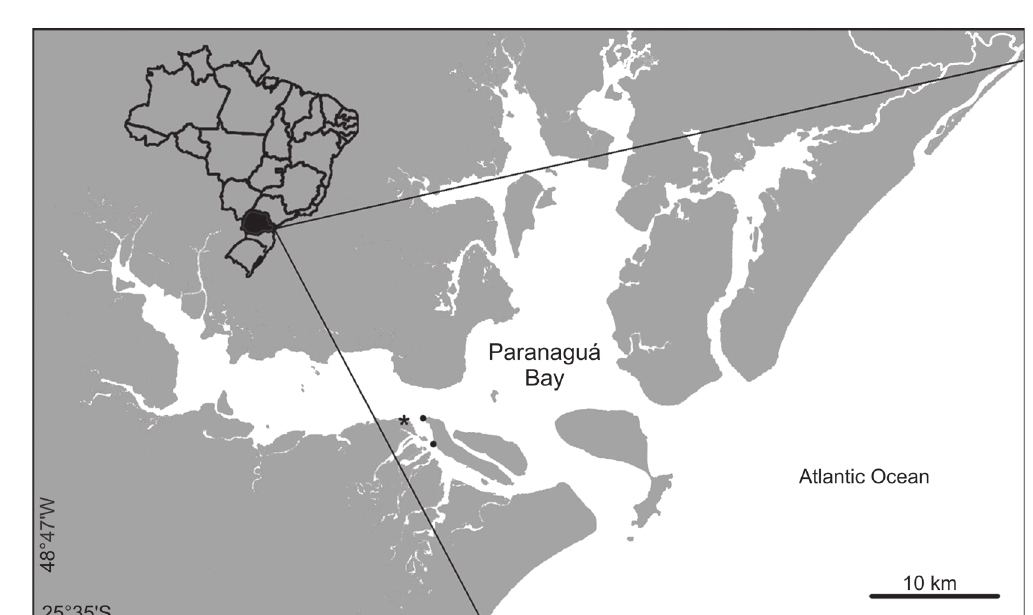
Figure 1. Map of Paranaguá Bay and its location in the state of Paraná (black area), Brazil (upper left). Dots represent surveyed locations at Cotinga island and the star, the Paranaguá